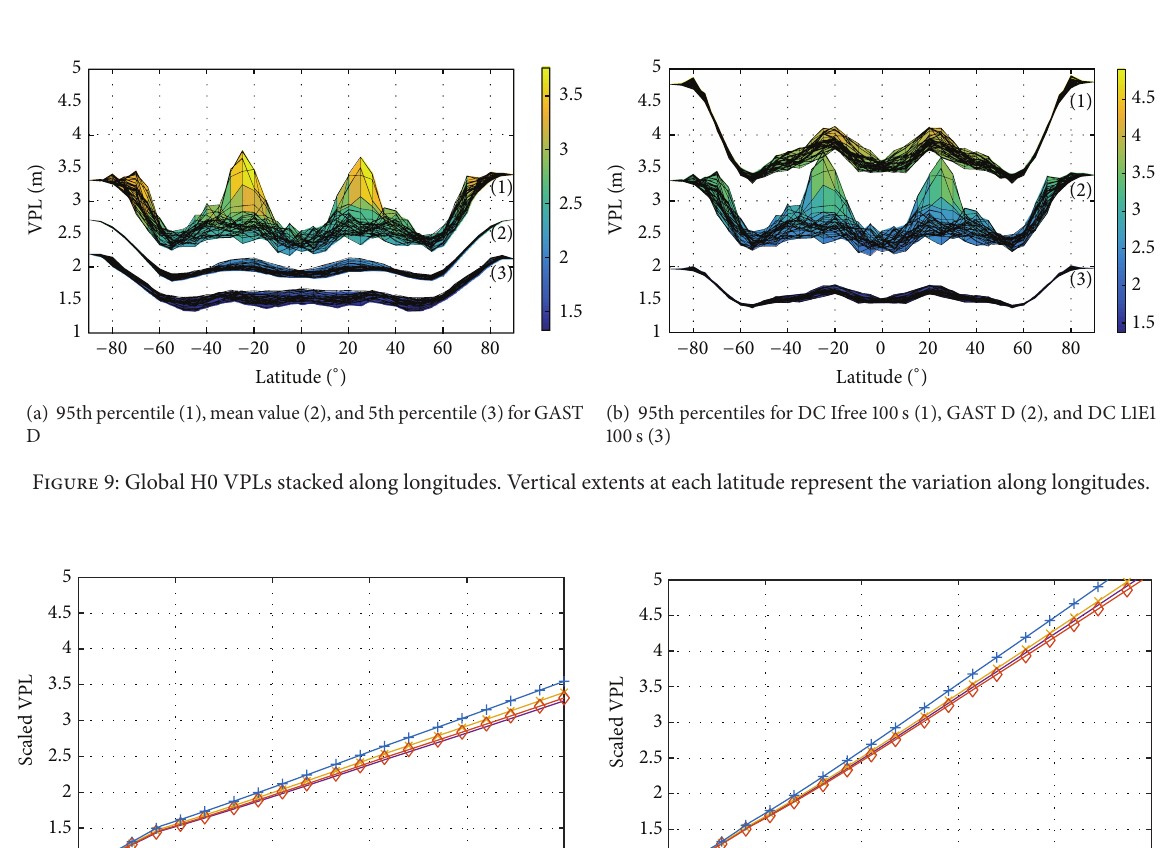
Figure 8: Global VPL for GAST D and exemplary comparison plot over time.